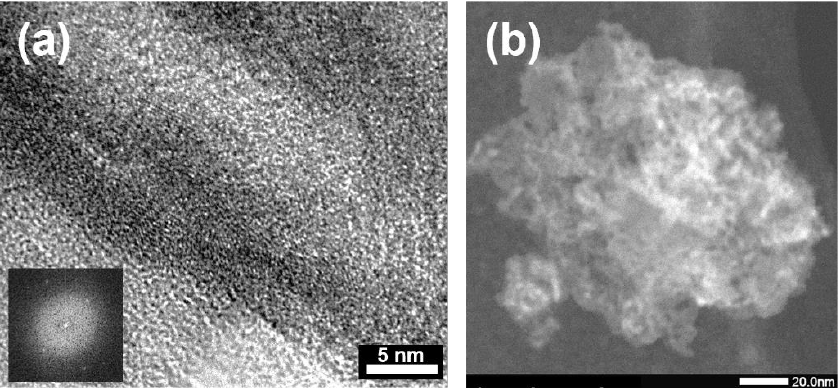
Figure 3. ( a ) HRTEM image of the Mn-nanozyme. The inset shows the presence of diffraction spots that confirm the crystalline nature of the MnO x needles; ( b ) STEM-HAADF images of the Mn-nanozyme.